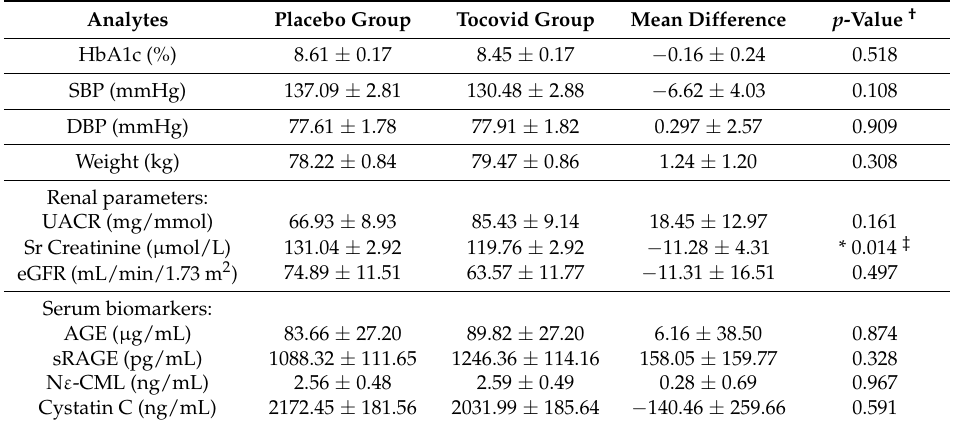
Table 8. Adjusted changes in metabolic, renal and biomarker parameters between placebo and Tocovid